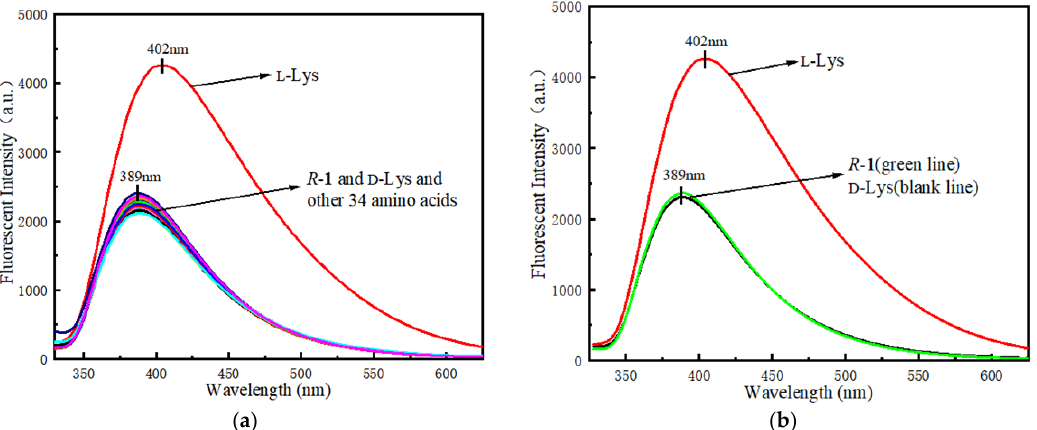
Figure 1. ( a ) Fluorescence spectra of R - 1 (2.0 × 10 −5 M in CH 3 OH) with different enantiomers of 18 ordinary amino acids (20.0 equivalents) (λ ex = 318 nm, slits = 5.0/2.5 nm); ( b ) fluorescence spectra of R - 1 (2.0 × 10 −5 M in CH 3 OH) toward D- and L-lysine (20.0 equiv.).